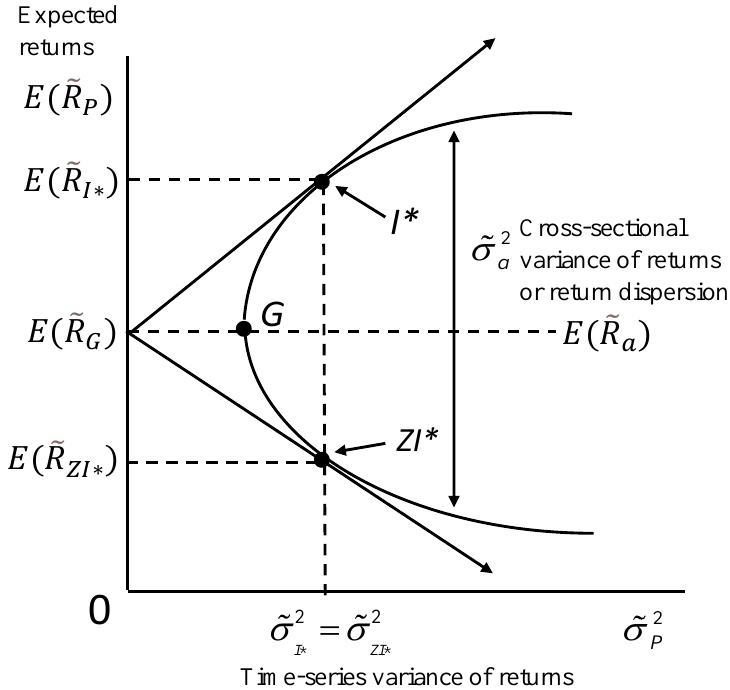
Figure 1. Geometric approach of the theoretical ZCAPM based on the Markowitz mean–variance investment